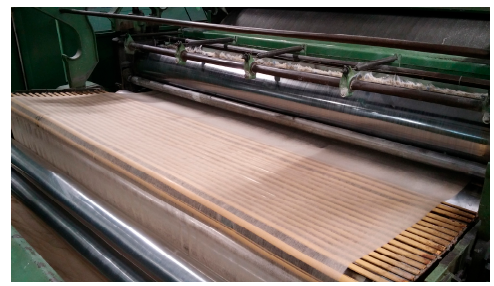
Figure 3. Final tow to be sent to the drawing.